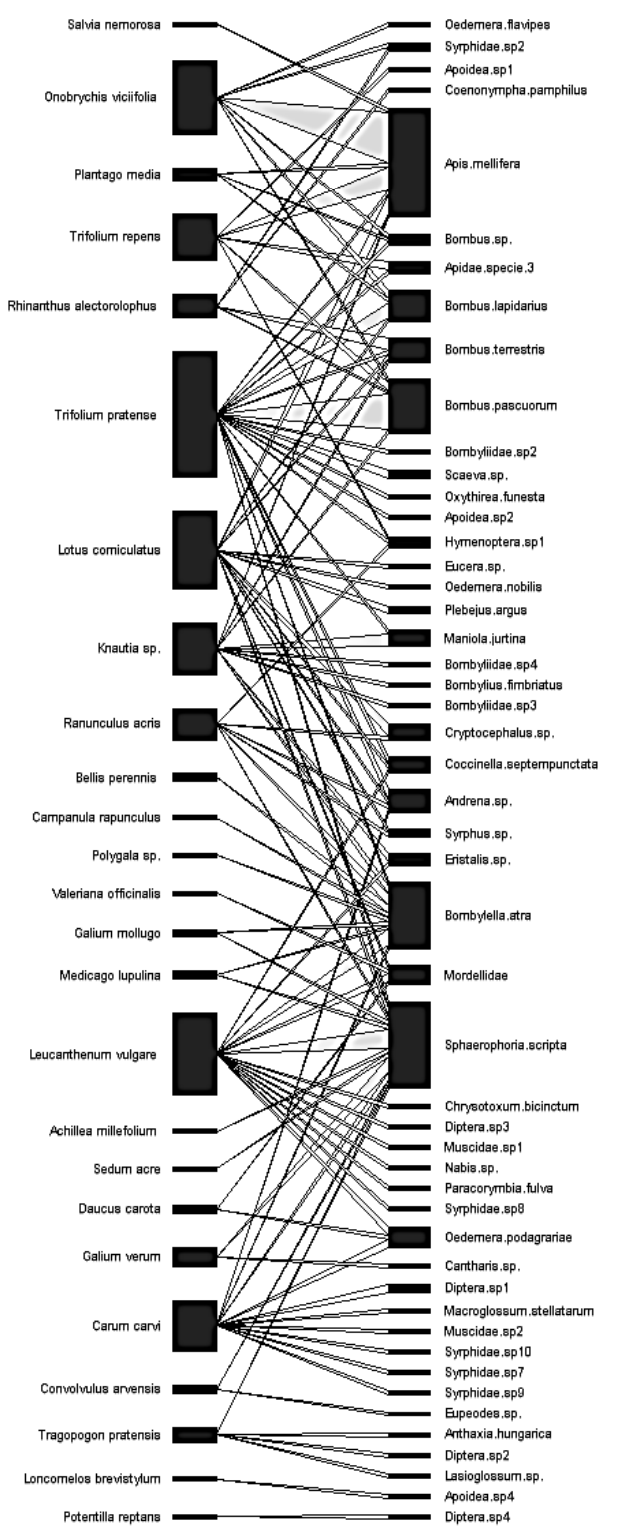
Figure 2. Plant pollination network of Apennines semi-natural grasslands based on the interaction frequency between pollinators and plants weighted on the floristic density of the plants with which the pollinators interacted. Pollinator species are listed at the top. Plant species are listed at the bottom. The width of the black bar indicates the interaction frequency of each species; the width of the grey line indicates the strength of interaction. Plant species authority are shown in Table